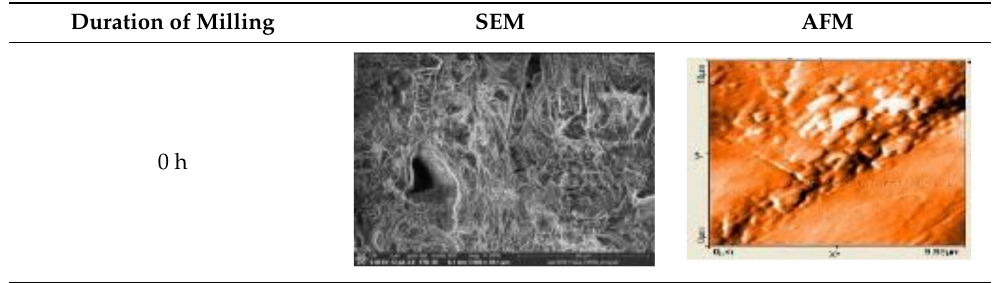
Table 8. SEM and AFM images for various milling times, 30 wt.% of